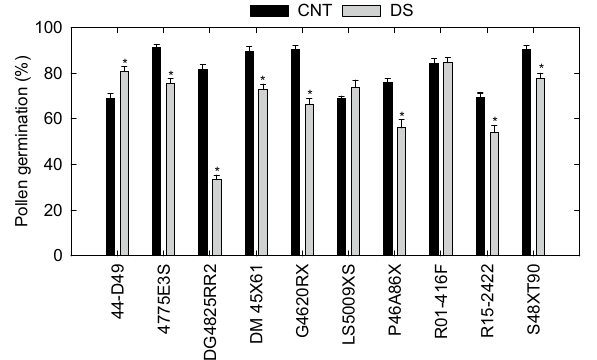
Figure 1. Pollen germination (%) of ten soybean cultivars under control (CNT) and drought stress (DS). The vertical bars represent mean of ten replicates ± SE. *indicates a significant difference between treatments at p < 0.05.